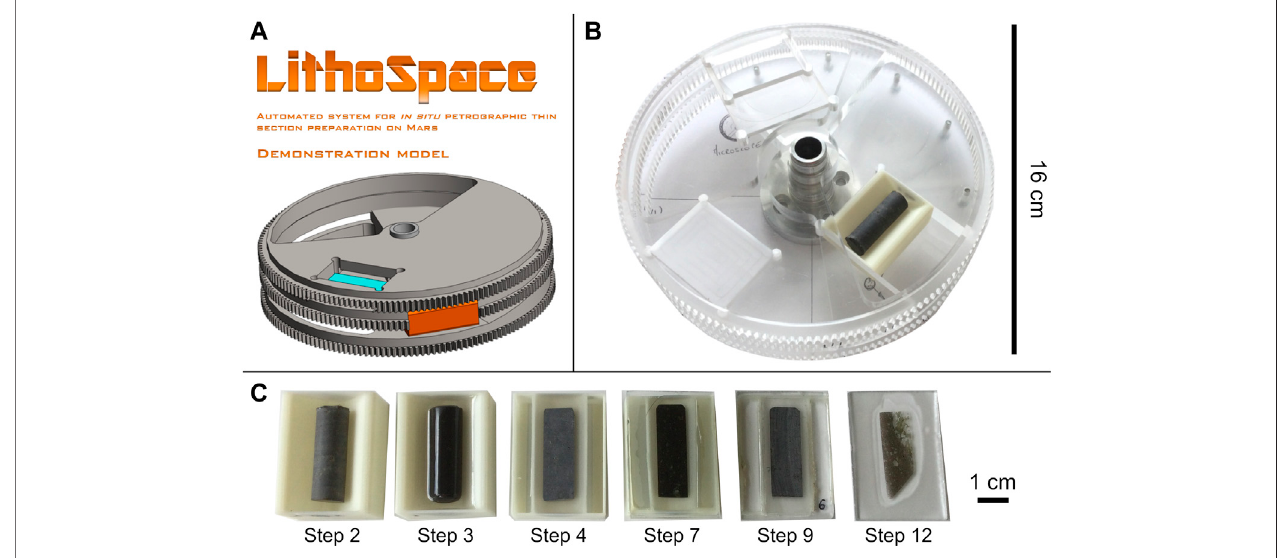
FIGURE 13 | LithoSpace demonstration model. (A) 3D model. (B) Physical model. (C) Samples representative to the different preparation steps (see Figure 11